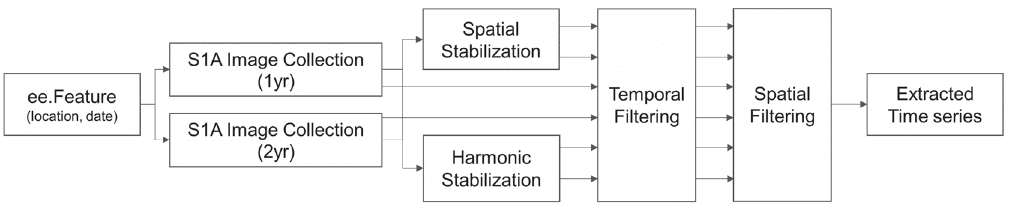
Figure 3. Pixel-wise time series extraction and processing sequence. All the steps were executed using the Google Earth Engine Python API.